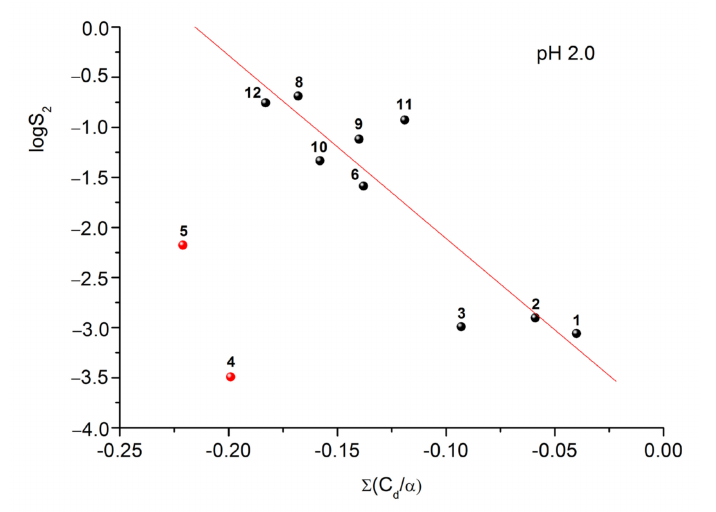
) versus Σ ( C ) descriptor. (compound numbering corresponds to d / α 2